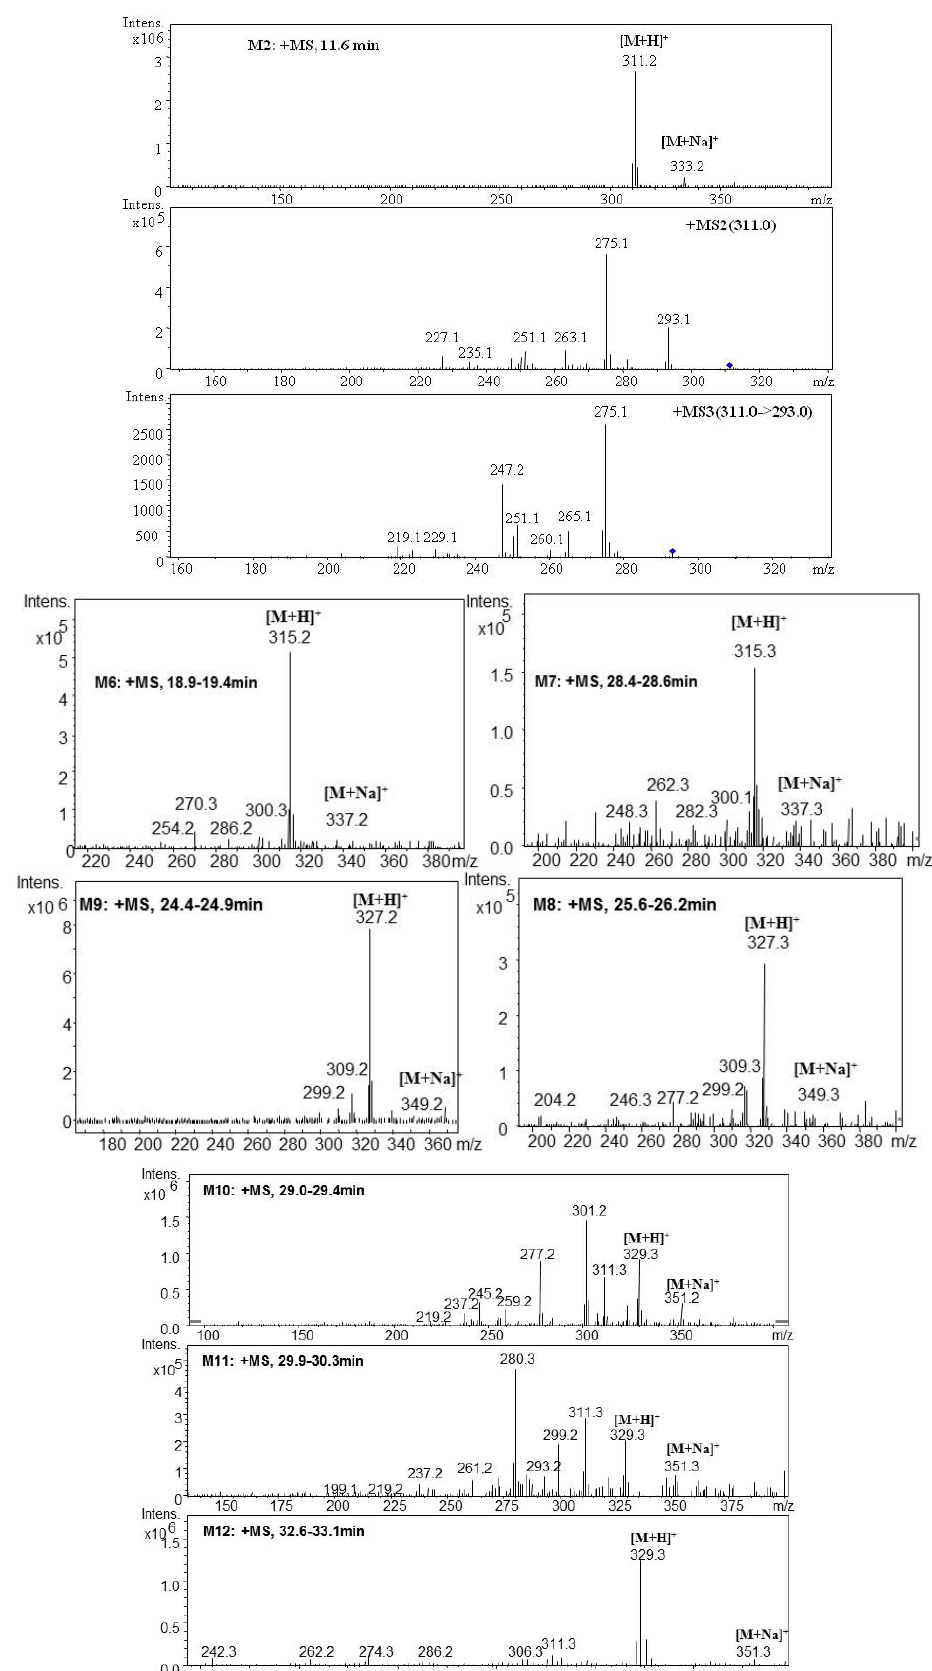
Figure 6. Positive ion ESI mass spectra and MSn spectra of metabolites components of TIIA and Cry by